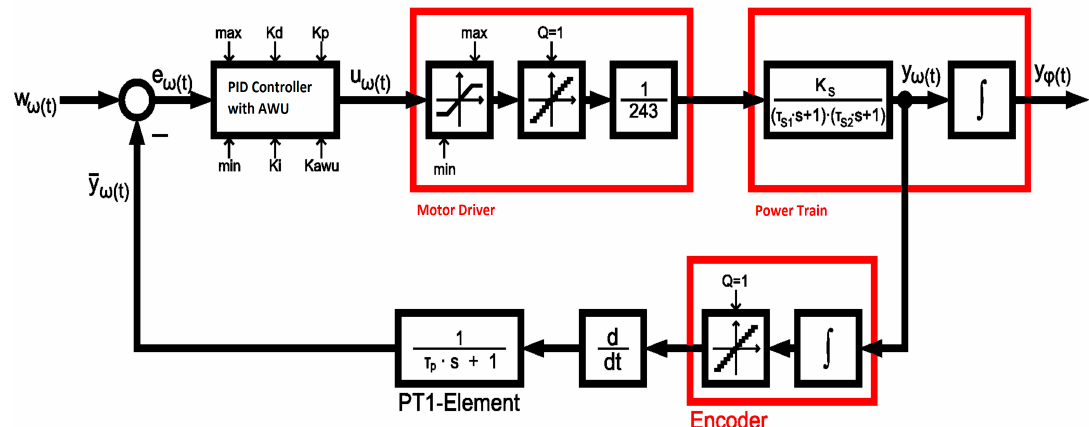
Figure 3. Speed control loop.